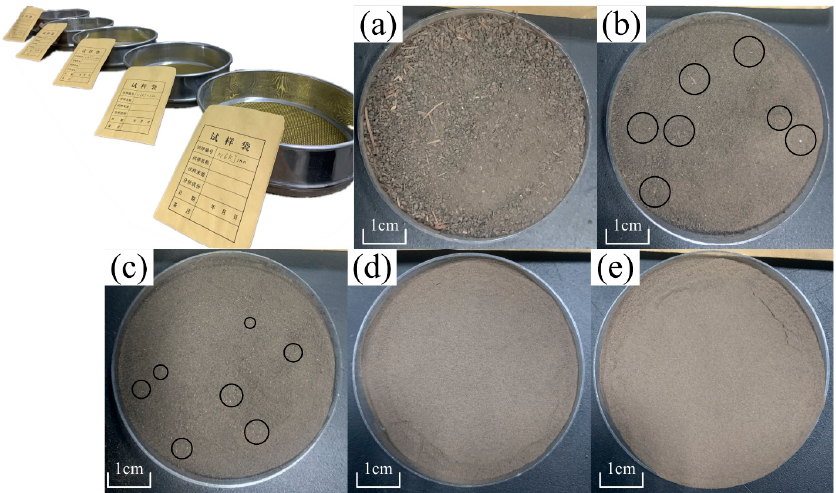
Figure 6. Standard diameter metal mesh soil sieves and sieved samples: ( a ) 1 mm sieved sample; ( b ) 0.5 mm sieved sample; ( c ) 0.25 mm sieved sample; ( d ) 0.1 mm sieved sample; and ( e ) 0.075 mm sieved sample.